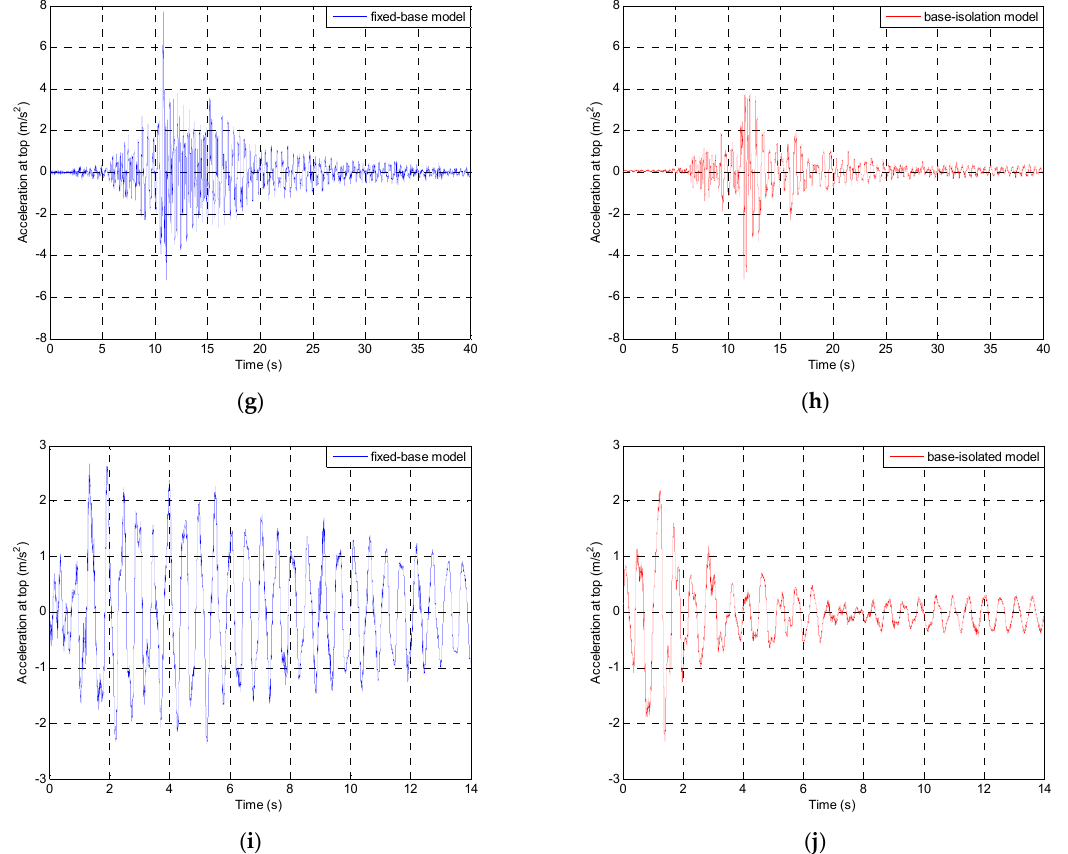
Figure 12. Time-acceleration history plots for the fixed-base (blue) and base-isolated (red) two-storey model during different earthquakes: the 1940 El Centro earthquake ( a , b ), the 1971 San Fernando earthquake ( c , d ), the 1989 Loma Prieta earthquake ( e , f ), the 1994 Northridge earthquake ( g , h ), and the 2002 Polkowice mining tremor ( i , j ). Table 1. Results of the seismic tests for the single-storey structure model. Peak Acceleration at the Top of the Tested Model (m/s 2 ) Dynamic Excitation Model Isolated Model with PBs